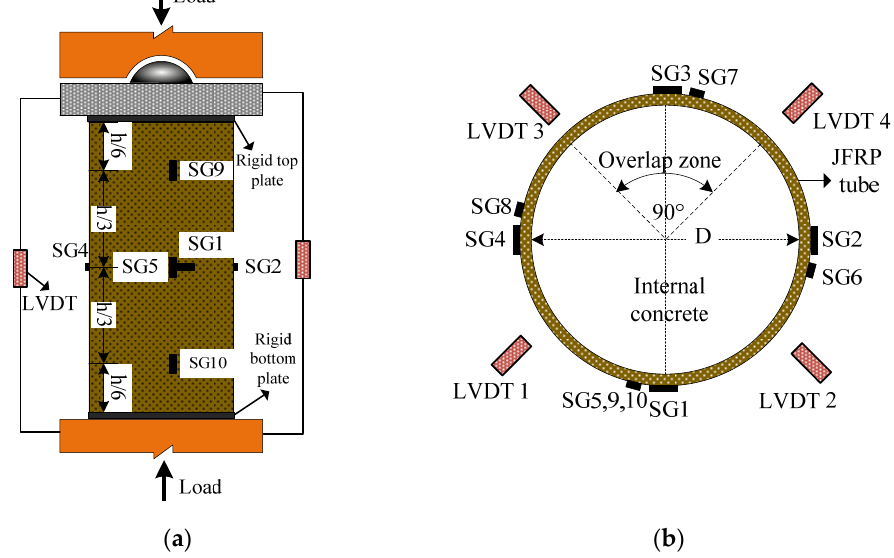
Figure 5. Test setup of the axial compressive tests: ( a ) overview and ( b ) the placement of strain gauges.